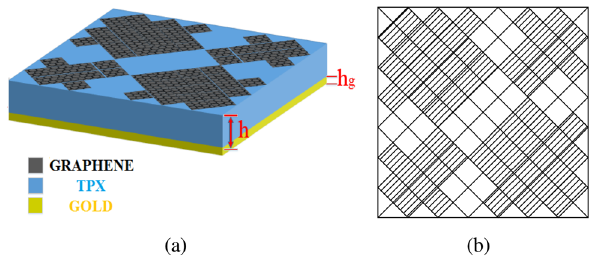
Figure 2. Structure of the fist optimized metasurface ( a ) 3-D view, ( b ) top view [001111110011100111111].